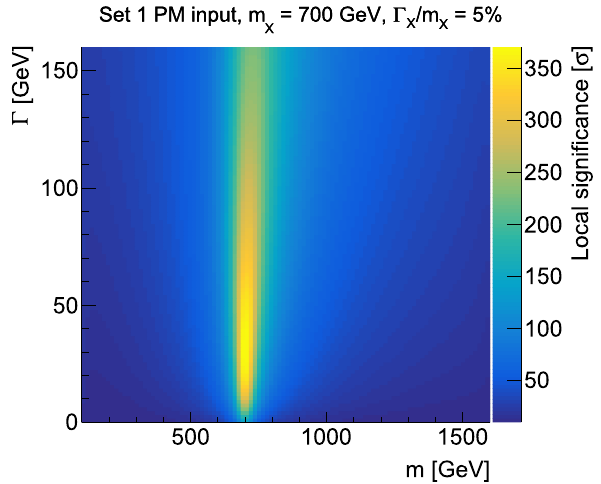
Fig. 11 Local significance for rejecting the background-only hypothe- sis, for an Asimov dataset corresponding to input mass m X = 700GeV and width (cid:3) X = 35GeV. The T a parametrisation of the template func- tional form is used as the alternative